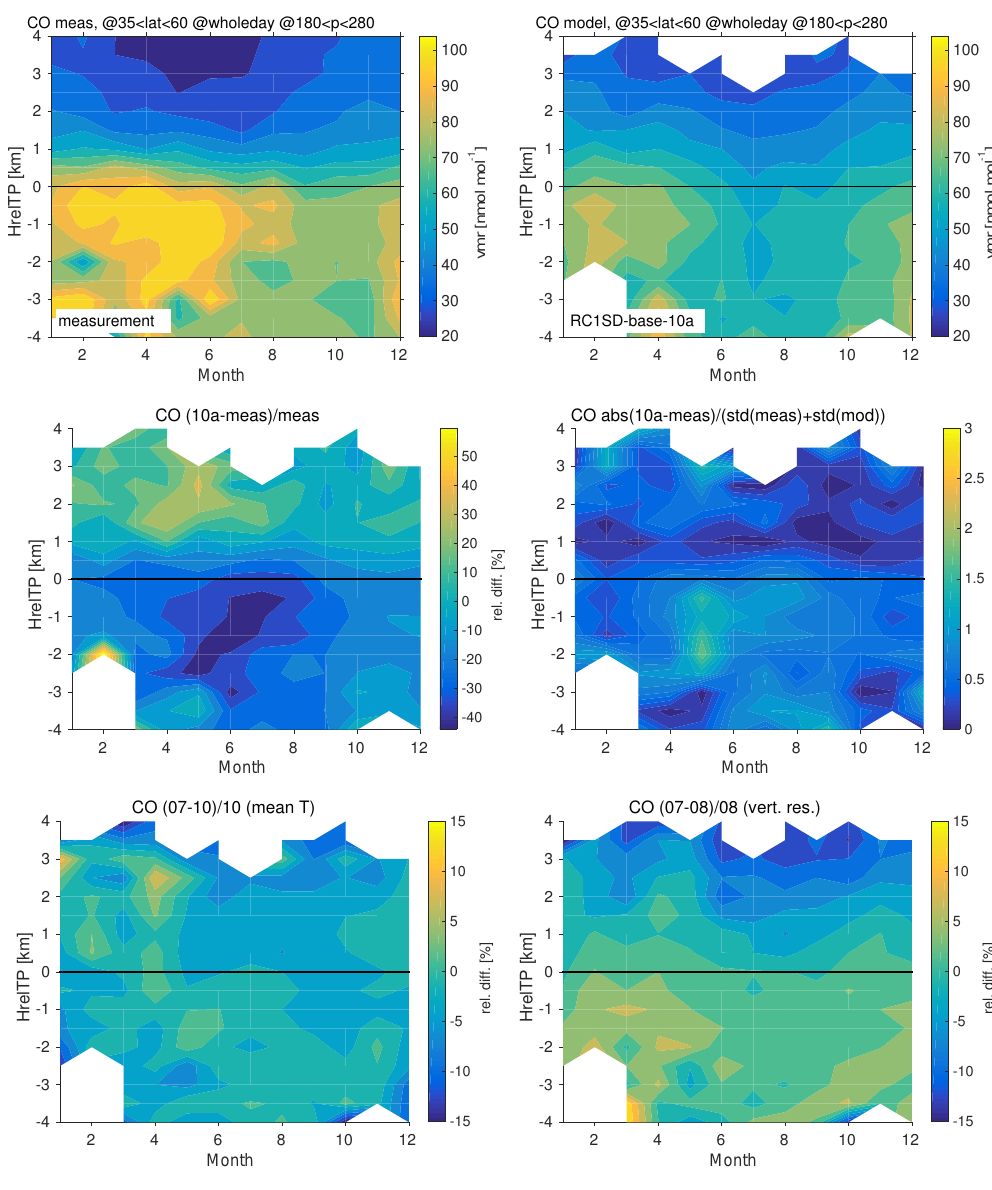
Figure 20. As Fig. 19, but for CO.